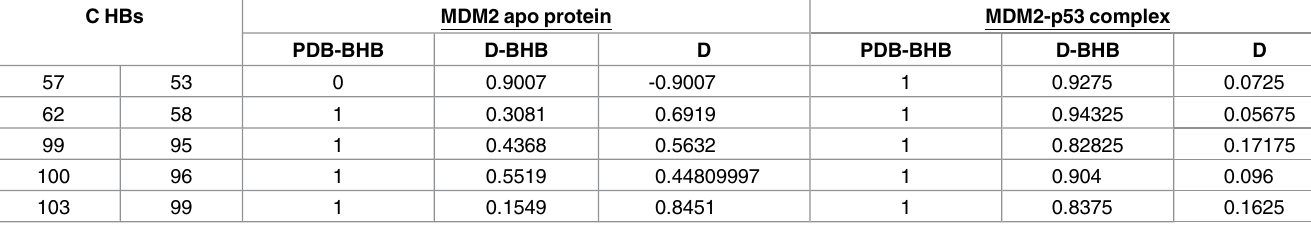
Table 1. Hydrogen bond formation propensity for the C-HBs of MDM2, both in the apo protein and in the p53-MDM2 wild-type complex. In both cases, we denote as PDB-BHB the state value of the BHB in the PDB (1 = formed; 0 = not formed), D-BHB is the fraction of time the BHB is formed in the dynamics and the value D is given by: D = PDB-BHB—D-BHB. We note there that the C-HBs are determinedin the apo protein and they are named as such also when considered in the complex. From their behavior in the protein complex we wouldnot identify them as C-HBs. Thus, C-BHs are “quenched” upon